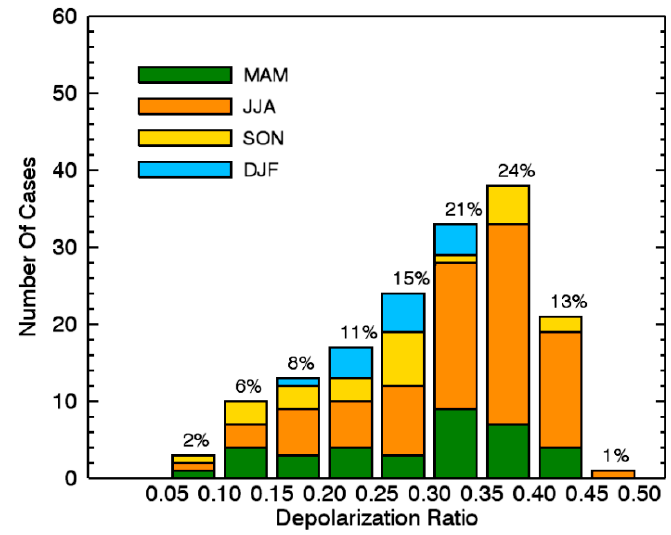
Figure 11. Histogram of cirrus particle depolarization ratio with seasonal proportion. Note that the cirrus particle depolarization ratio is distributed in the range of 0.07–0.49 with the most probable values being 0.3–0.4.